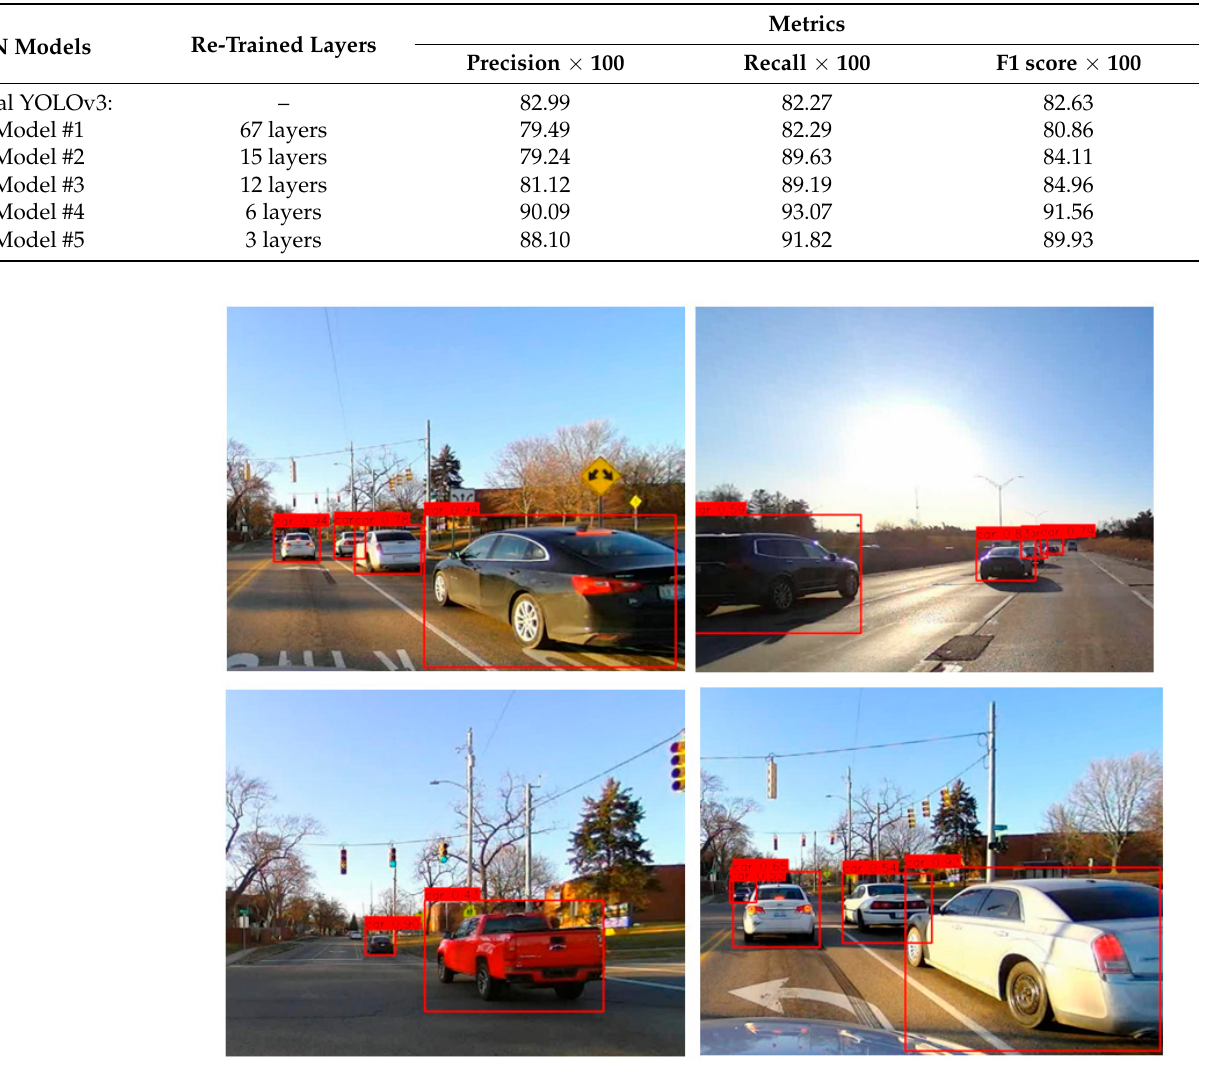
Figure 10. Examples of detection results by TL Model #4. The detected vehicles are marked with red bounding boxes.